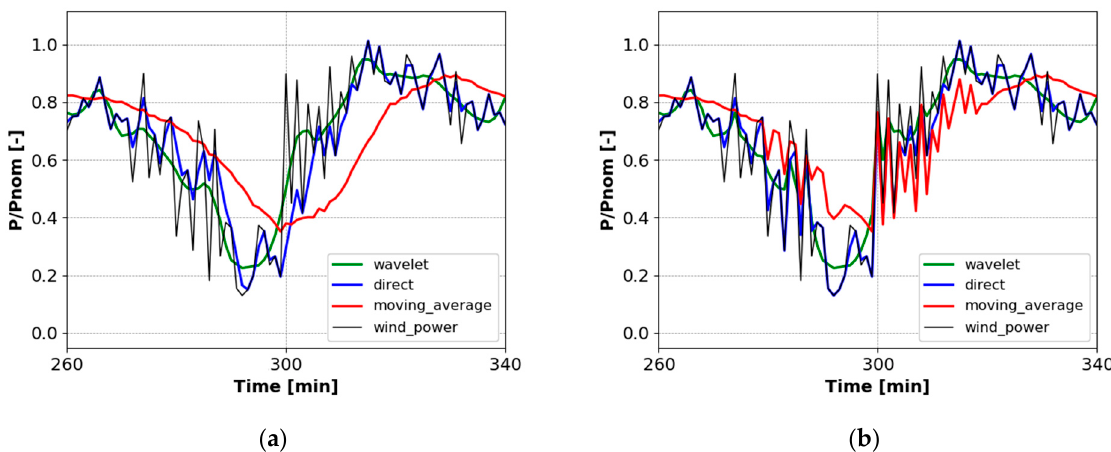
Figure 16. Detailed comparison between the different smoothing techniques: ( a ) theoretical power smoothing ( b ) power